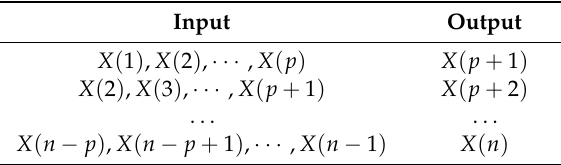
Table 1. Reconstructed